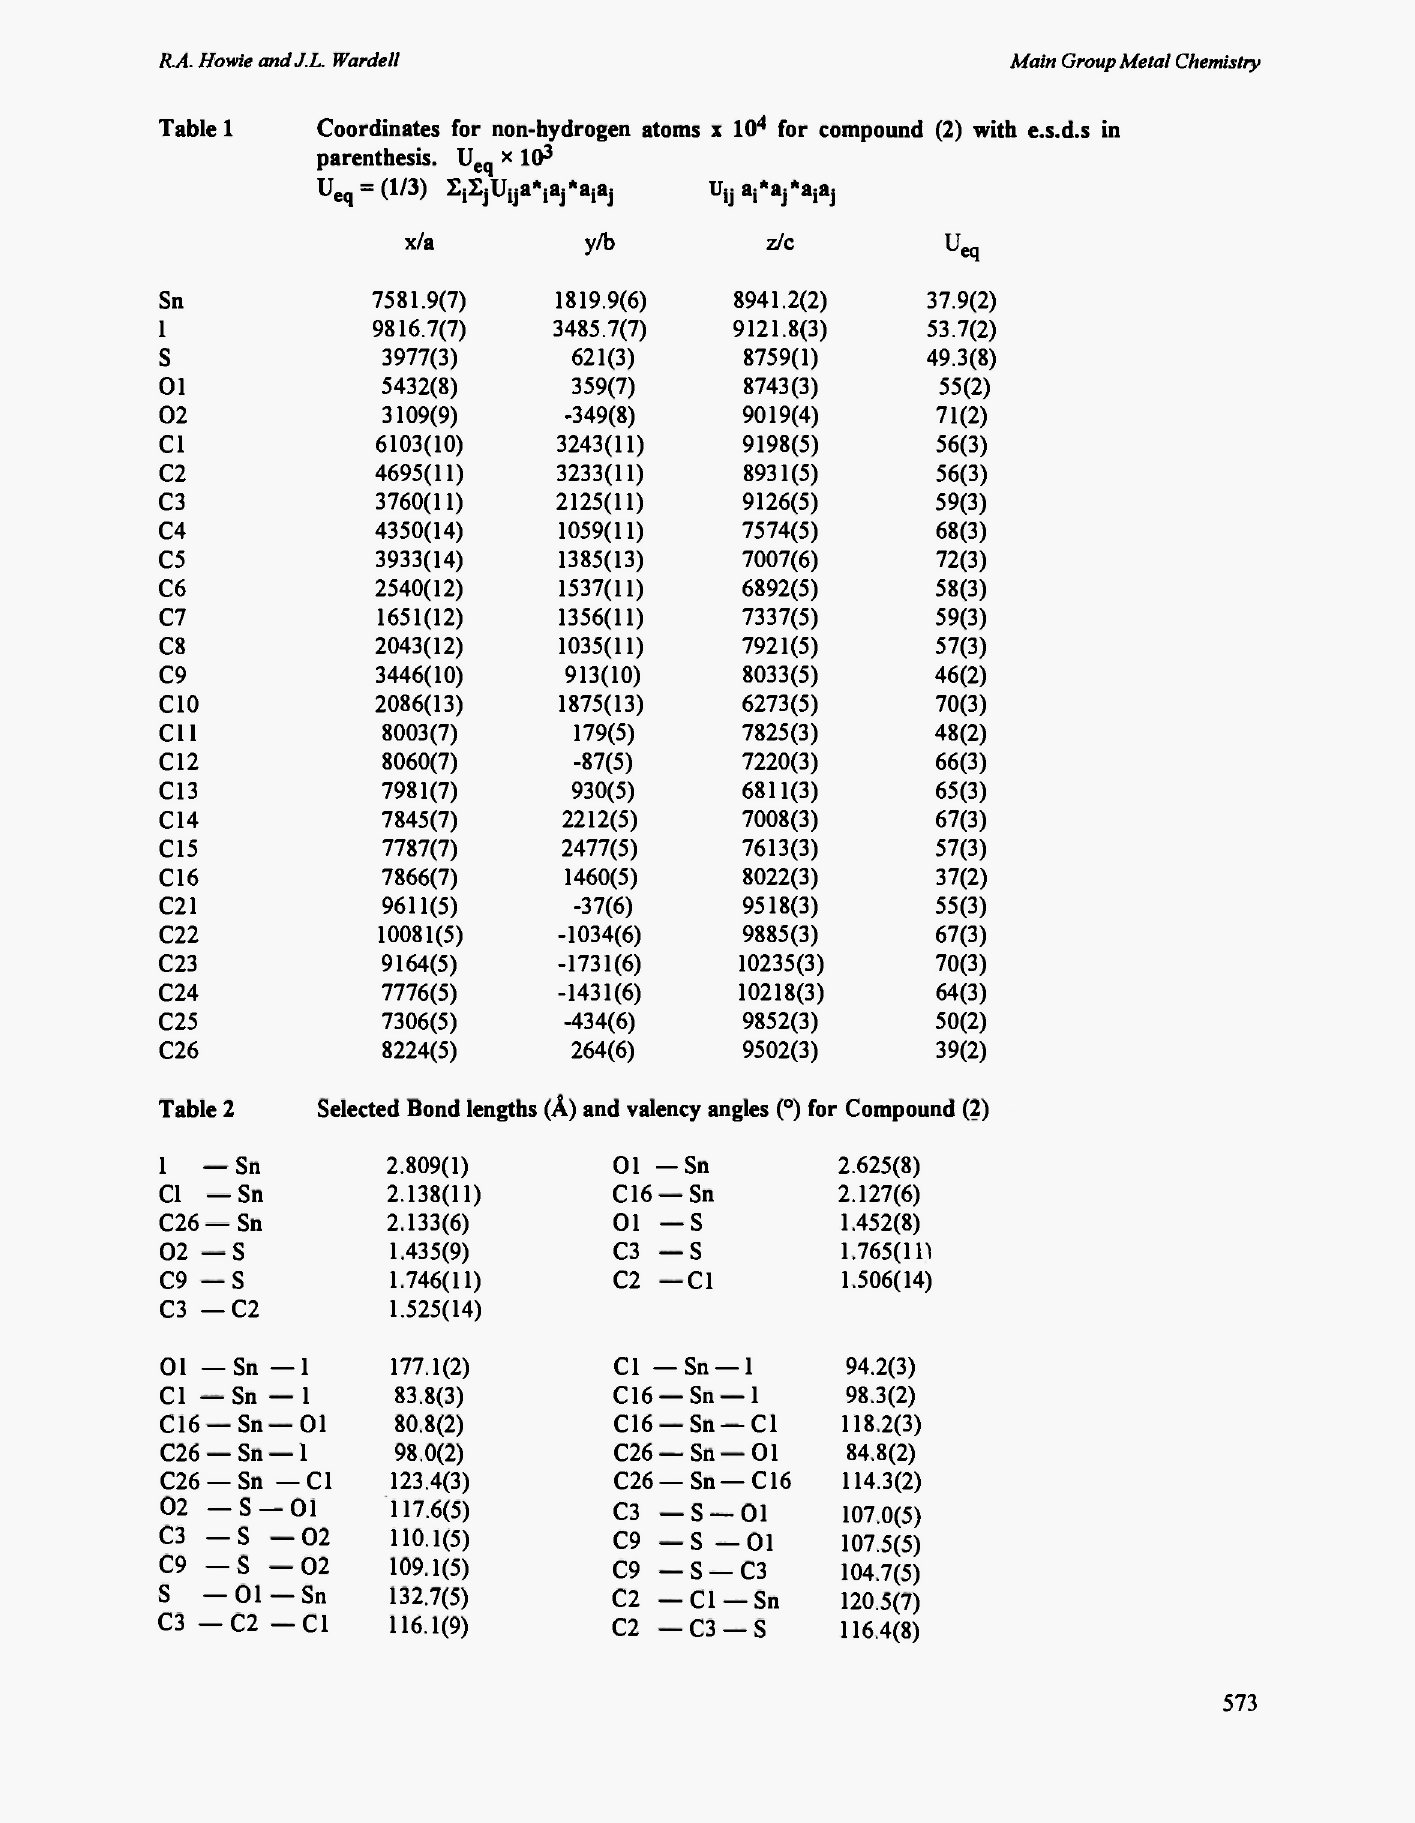
Coordinates for non-hydrogen atoms χ 10 4 for compound (2) with e.s.d.s in parenthesis. U eq x 10 3